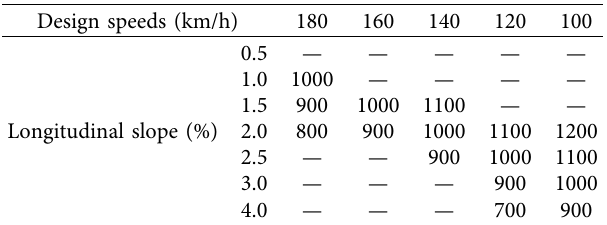
Table 11: Maximum slope length (unit: